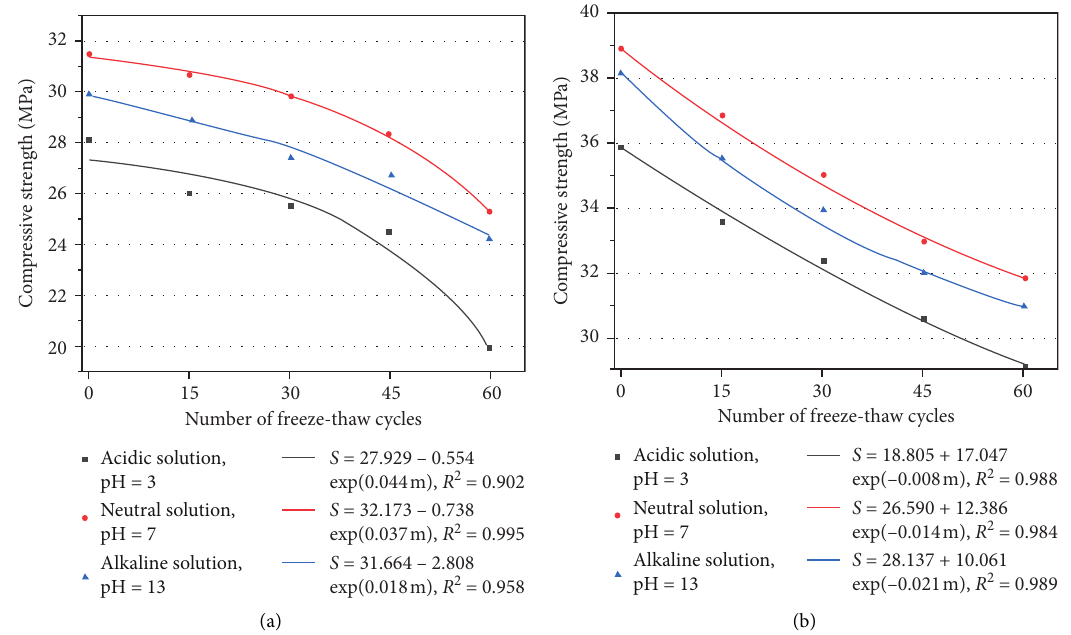
Figure 9: Curves of compressive strength and number of freeze-thaw cycles of sandstone samples under different chemical erosions: (a) compressive strength curves at a confining pressure of 3 MPa; (b) compressive strength curves at a confining pressure of 6 MPa. S is the compressive strength of the sandstone samples subjected to m times freeze-thaw cycles under different chemical solutions. R 2 is the correlation